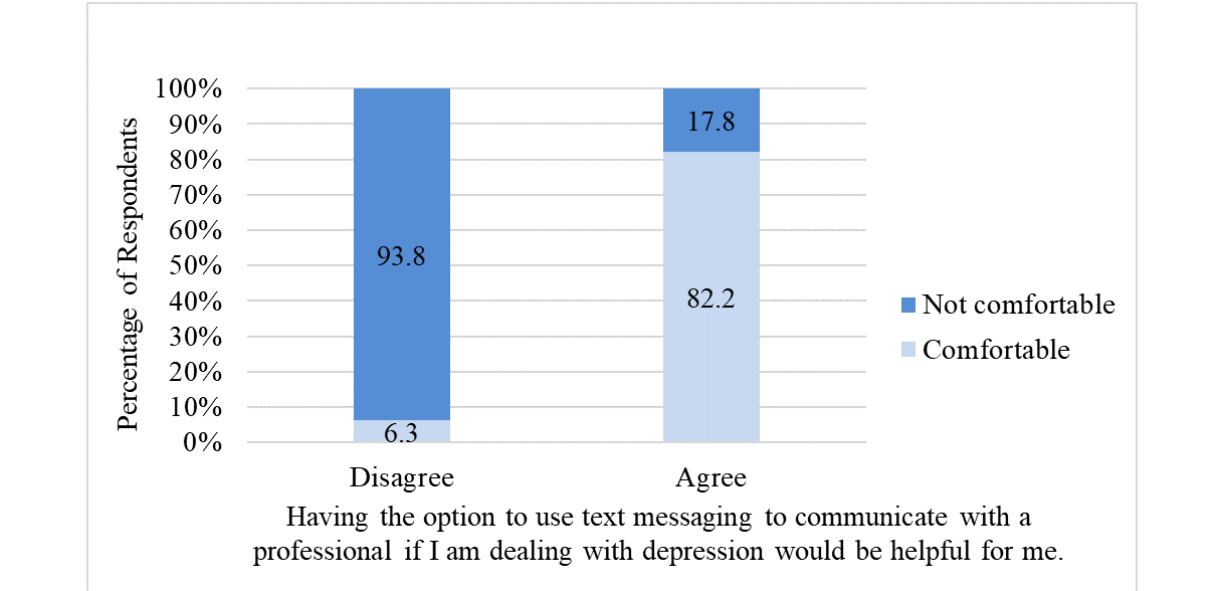
Figure 2. Sample percentages showing the bivariate relationship between perceived helpfulness and comfortability with using text messaging to communicate with a professional to receive help to manage depression ( P &lt;.001). Note: percentages may not sum to 100% because of